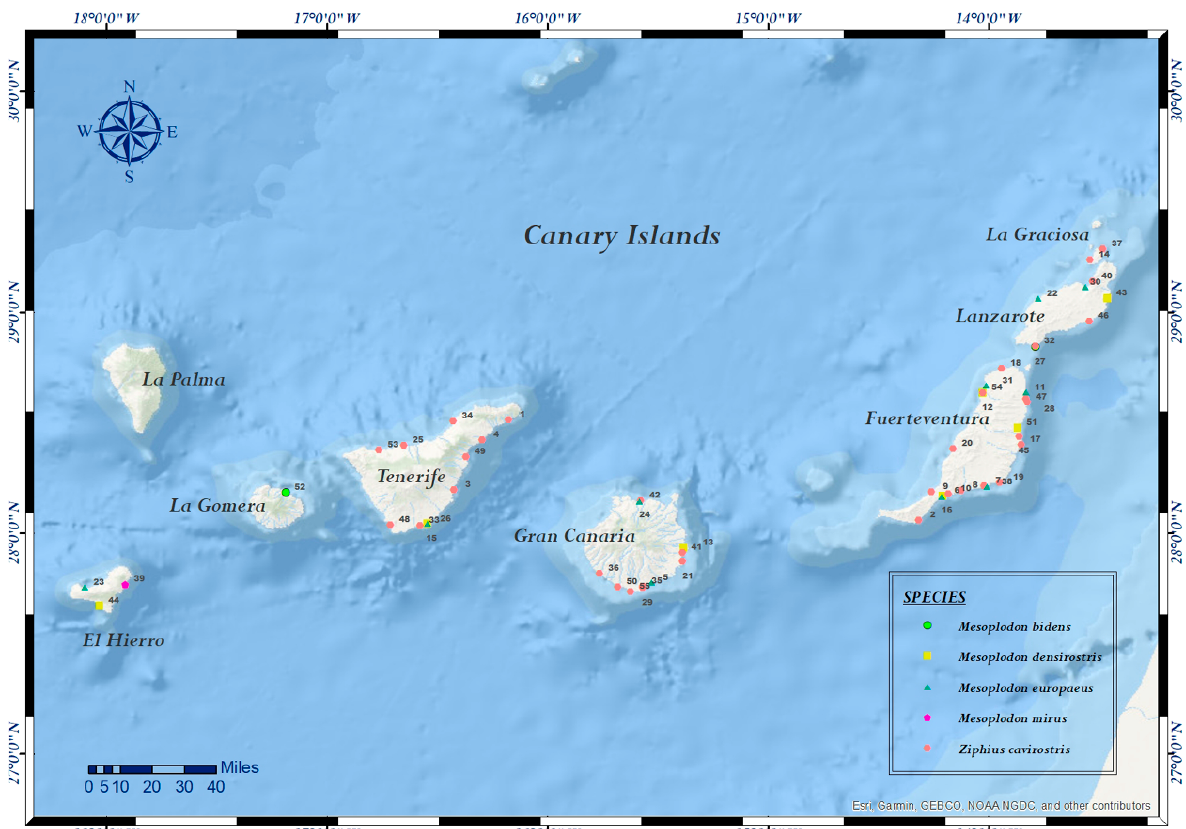
Figure 1. Map of the geographical distribution of beaked whales stranded in the Canary Islands between 1997 to 2017. Stranding sites for each beaked whale is identified by its case number. The species are represented with different colours.